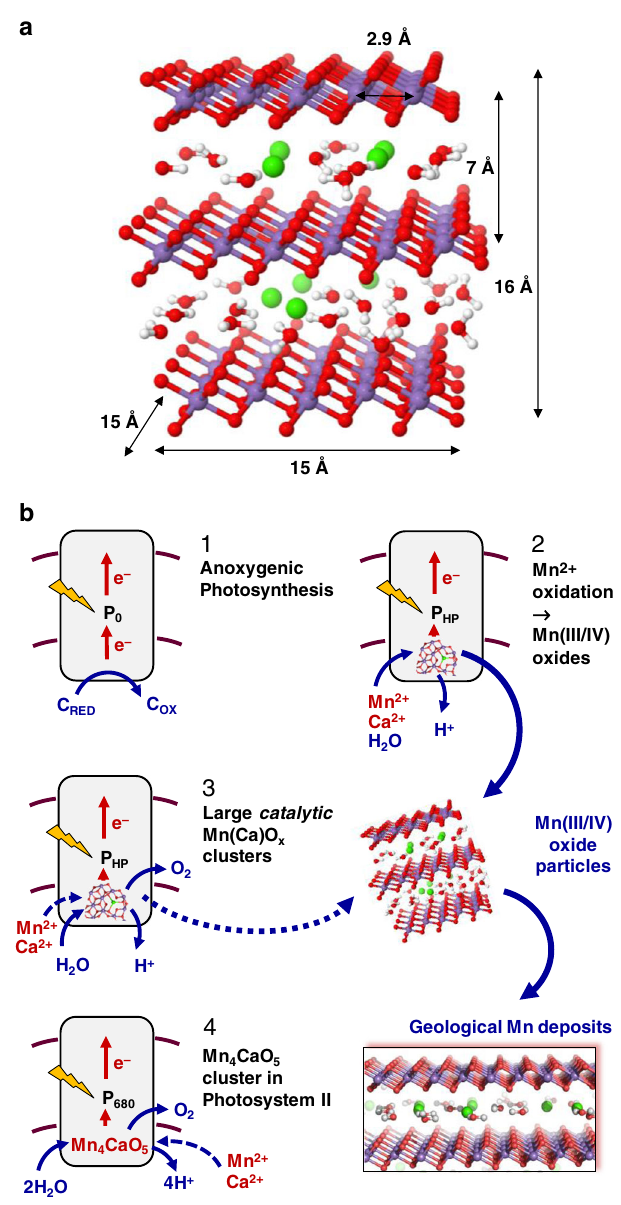
Fig. 6 Evolution of oxygenic photosynthesis and relation to geological Mn-oxide deposits. a Structural model of a birnessite fragment with 64 Mn ions (based on published atomic coordinates, protons were added for illustration only). Atom color coding: violet, Mn(III/IV) ions; red, O or OH; green, Ca 2 + ; gray, H. b Proposed sequence of evolutionary events. (1) Starting from an early anoxygenic photosystem in a cyanobacterial ancestor, either with a low-potential or a high-potential primary donor, (2) a variant with suitable donor potential (P HP ) and metal-binding site facilitated Mn 2 + oxidation to generate protein-bound Mn(III,IV)-oxide clusters, which upon sedimentation contributed to geological Mn-oxide deposits. (3) The PSII-bound clusters developed into primordial water- oxidizing and O 2 -evolving catalytic complexes, which, (4) due to a dedicated binding site, were down-sized to the present Mn 4 CaO 5 catalyst. At some point, Mn-oxide particles also may have been involved in a quasi- respiratory